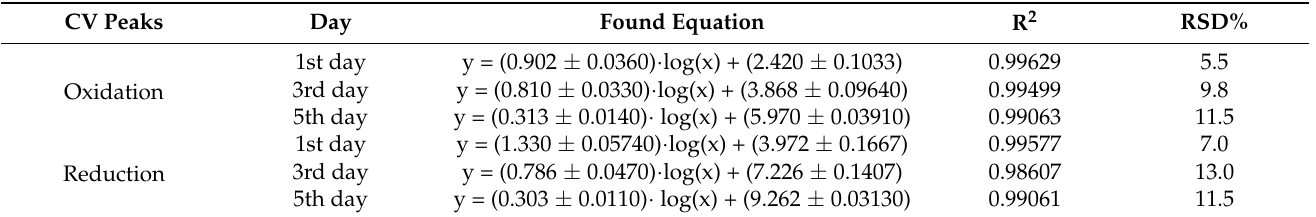
Table 2. Main analytical data of the straight-line curves displayed in Figure 7c,f, recorded in the first, third and fifth day from sensor fabrication.